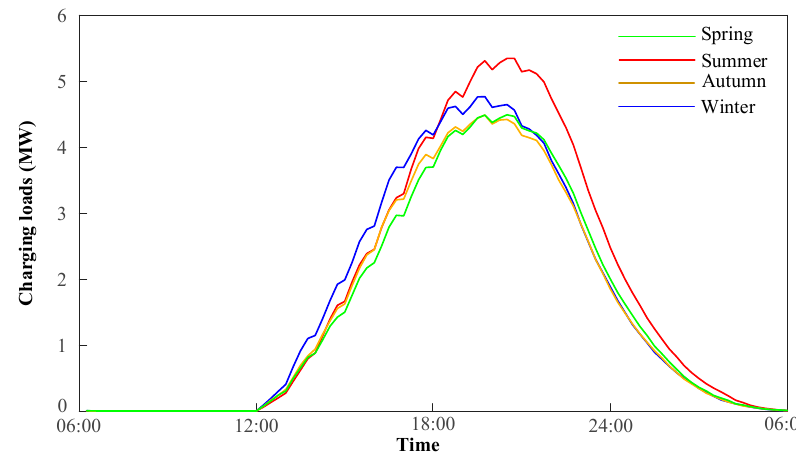
Figure 4. An example of daily charging load curves of 2000 electric vehicles.